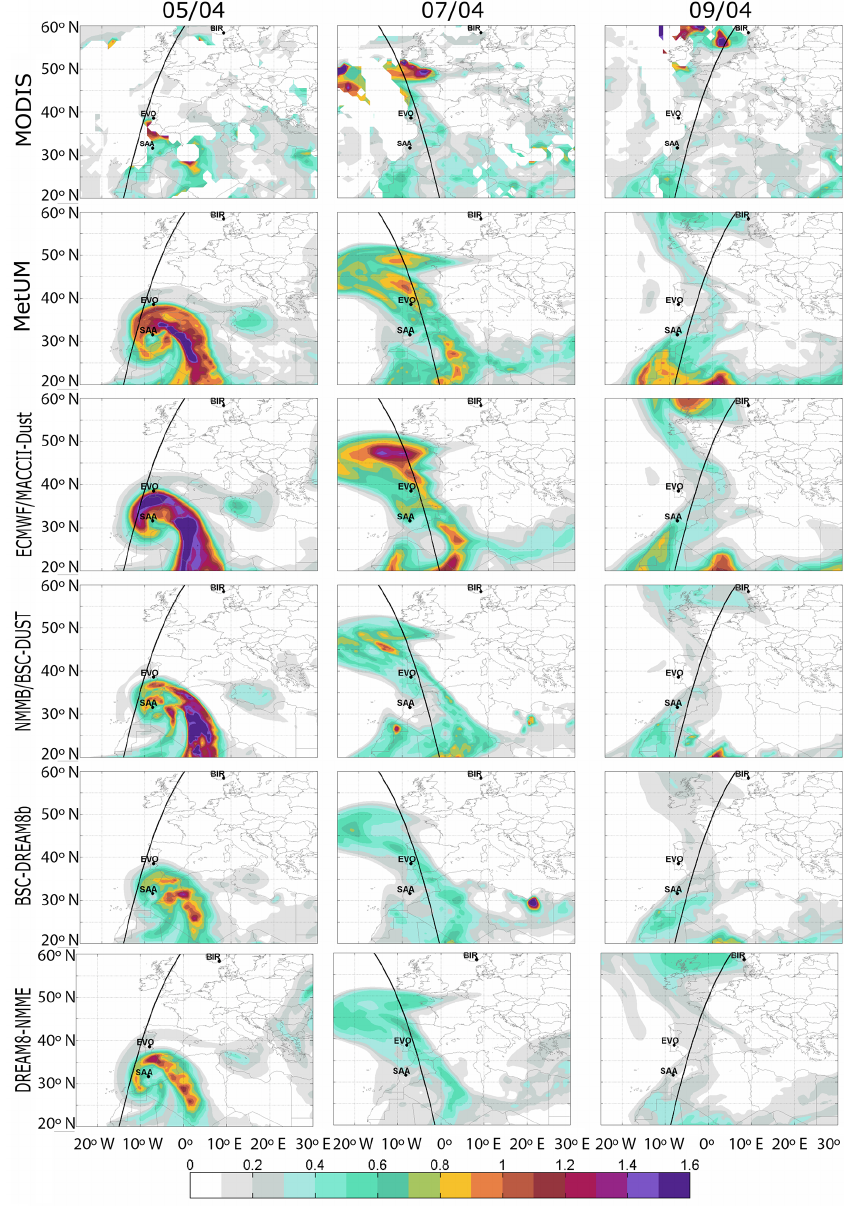
Figure 3. Maps of daily total AOD at 550nm from MODIS (first row) and corresponding 24h forecasts of models MetUM (second row), ECMWF/MACC (third row), NMMB/BSC-DUST (fourth row), BSC-DREAM8b (fifth row) and DREAM8-NMME (sixth row) for 5 April (first column), 7 April (second column) and 9 April (third column) 2011. Corresponding maps for all days between 4 and 11 April are given in Fig. S01, and 48 and 72h forecast maps are provided in Figs. S02 and S03. The three AERONET sites shown in Fig. 2 (black dots) and the CALIPSO orbits (black lines) are also shown. The simulated AOD is computed as the average of the fields at 12:00 and